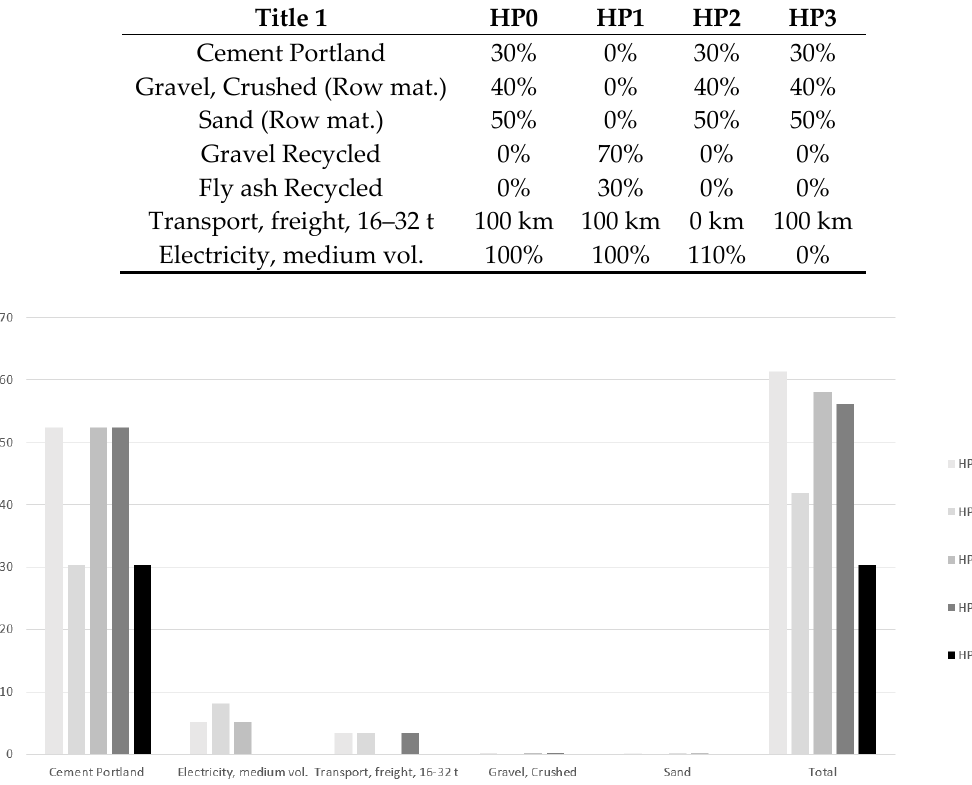
Figure 1. The figure shows the various scenarios compared in terms of GHG emissions, in scenario of Climate Change—GWP 100a, express in Kg of